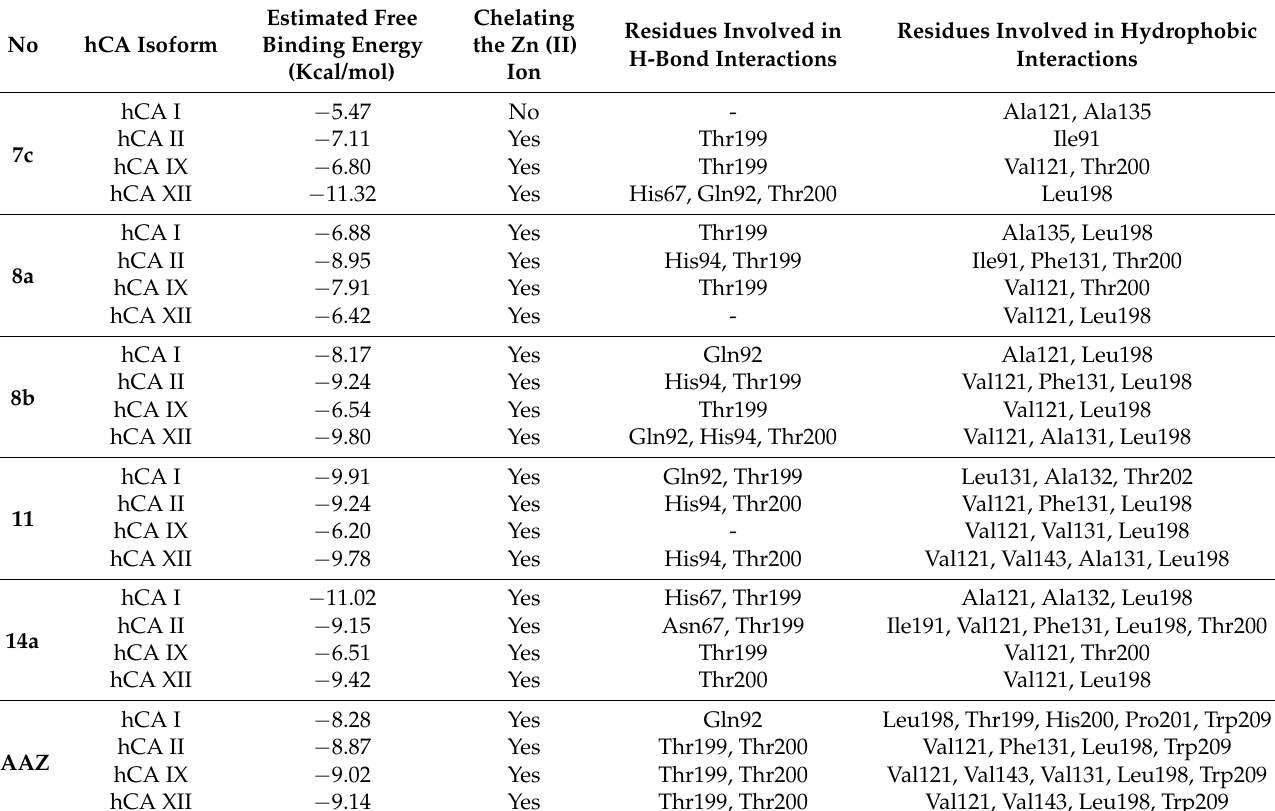
Table 2. Molecular docking free binding energies (kcal/mol) and interactions of tested compounds on hCA I, II, IX, and XII